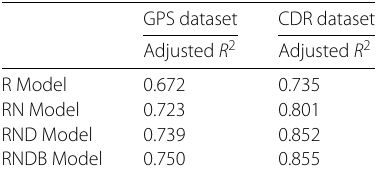
Table 5 Variation in entropy explained by each of the proposed regression models (adjusted R 2 ) for both datasets, in the next-place prediction task. The R model is the model that uses regularity, and the RD model is the one where diversity of trajectories is also used, along with regularity. We also include results for the RDN model, which in addition to regularity and diversity also uses the size n of ones routine, and the RDNB model, which adds information about the baseline entropy of one’s